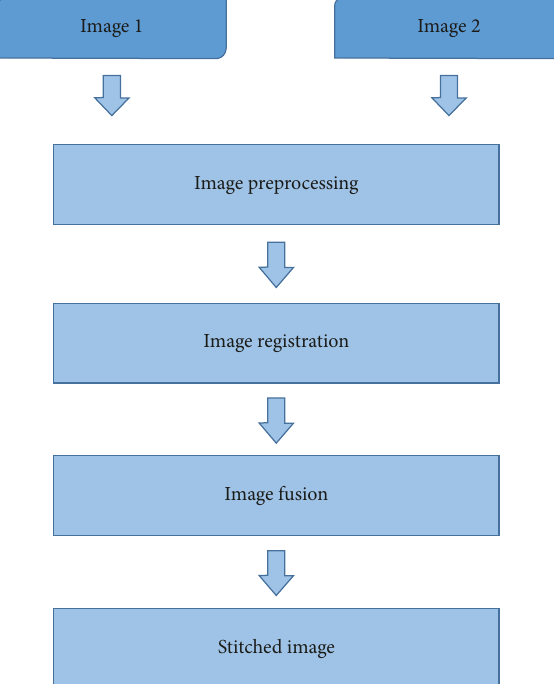
Figure 2: The basic process of image difference. Figure 2 is the corresponding flow chart. Image acquisition is to capture real-time raw images and lay a solid foundation for panoramic stitching [9]. In general, image projection is included in addition to image correction and denoising. Image registration is to find a suitable spatial transformation and align the coordinate points at the overlap. After the images are registered, the image stitching operation can be performed. Because of grayscale differ- ences, seams and brightness differences are prone to occur.